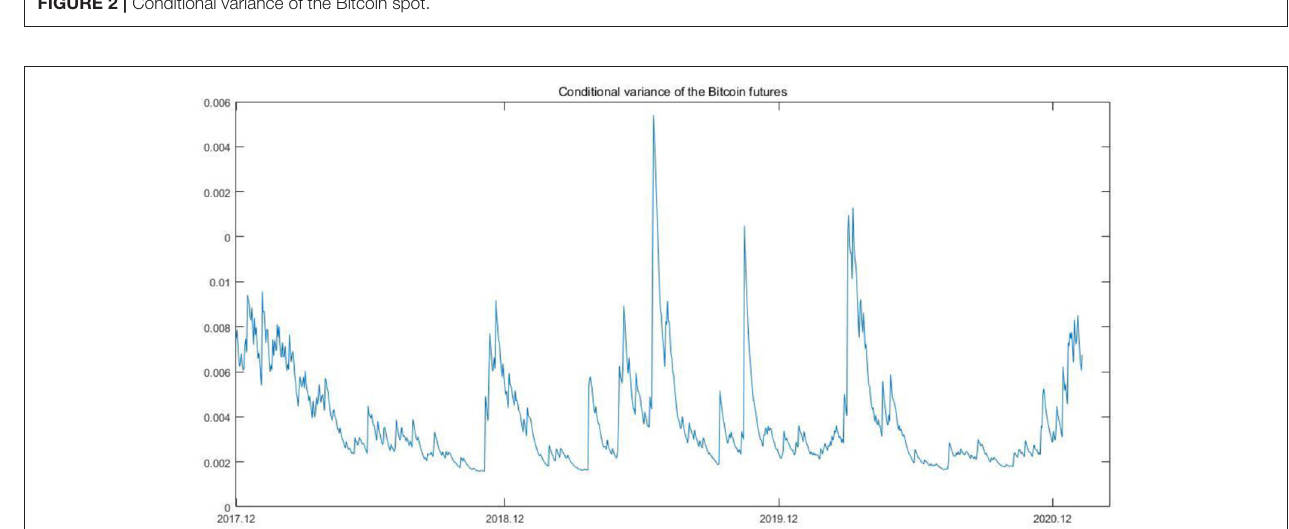
FIGURE 2 | Conditional variance of the Bitcoin spot.